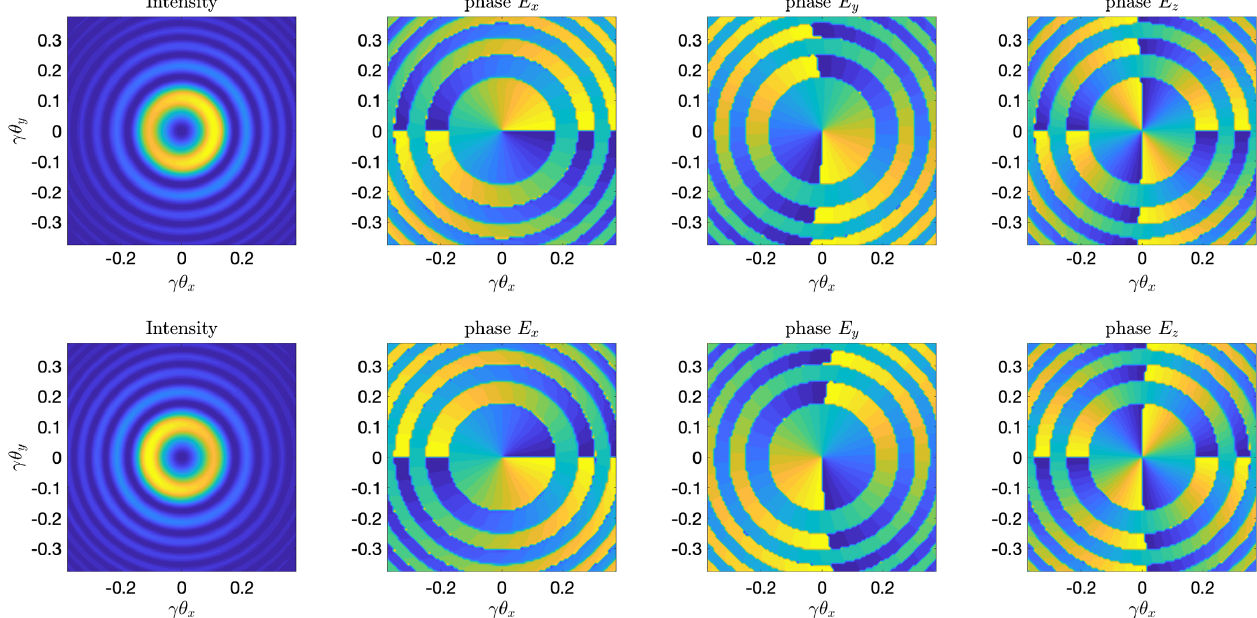
¼ 100 , K ¼ 2 . 3 , γ ¼ 7828 u